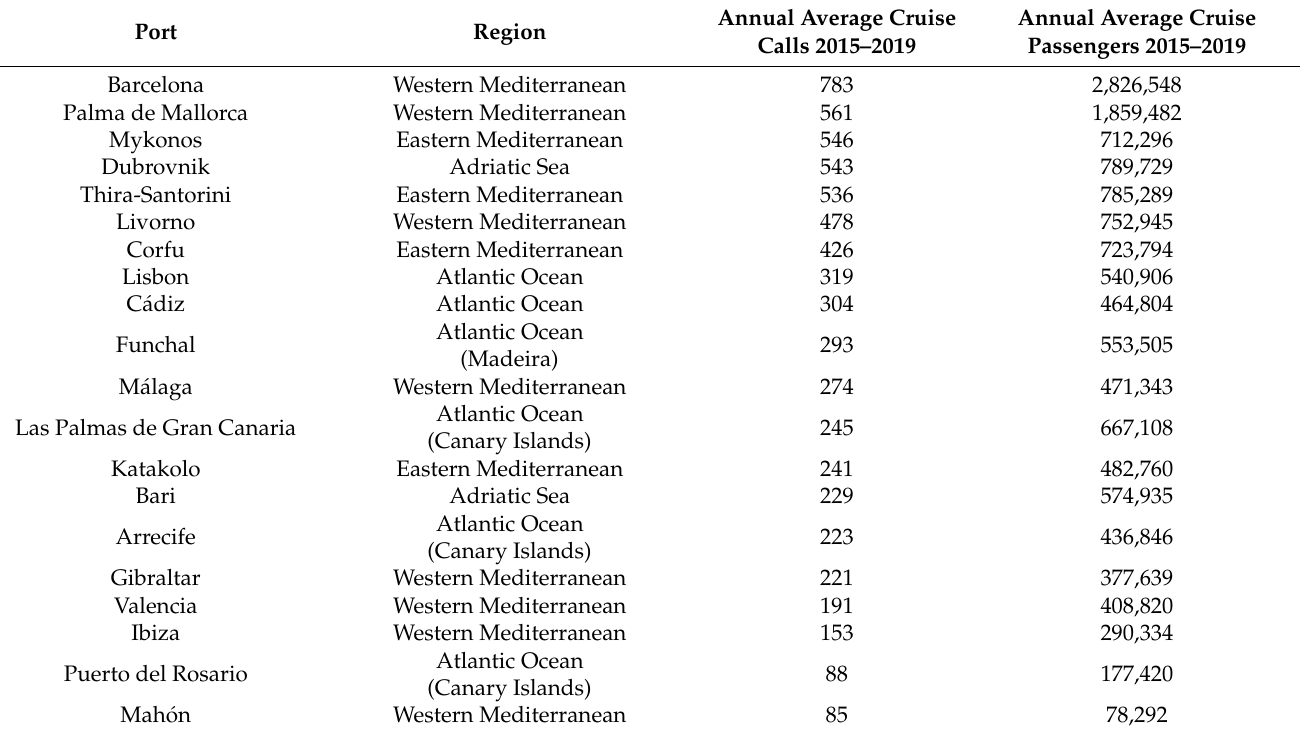
Table 1. Key performance indicators of cruise shipping of the ports of the sample during the period